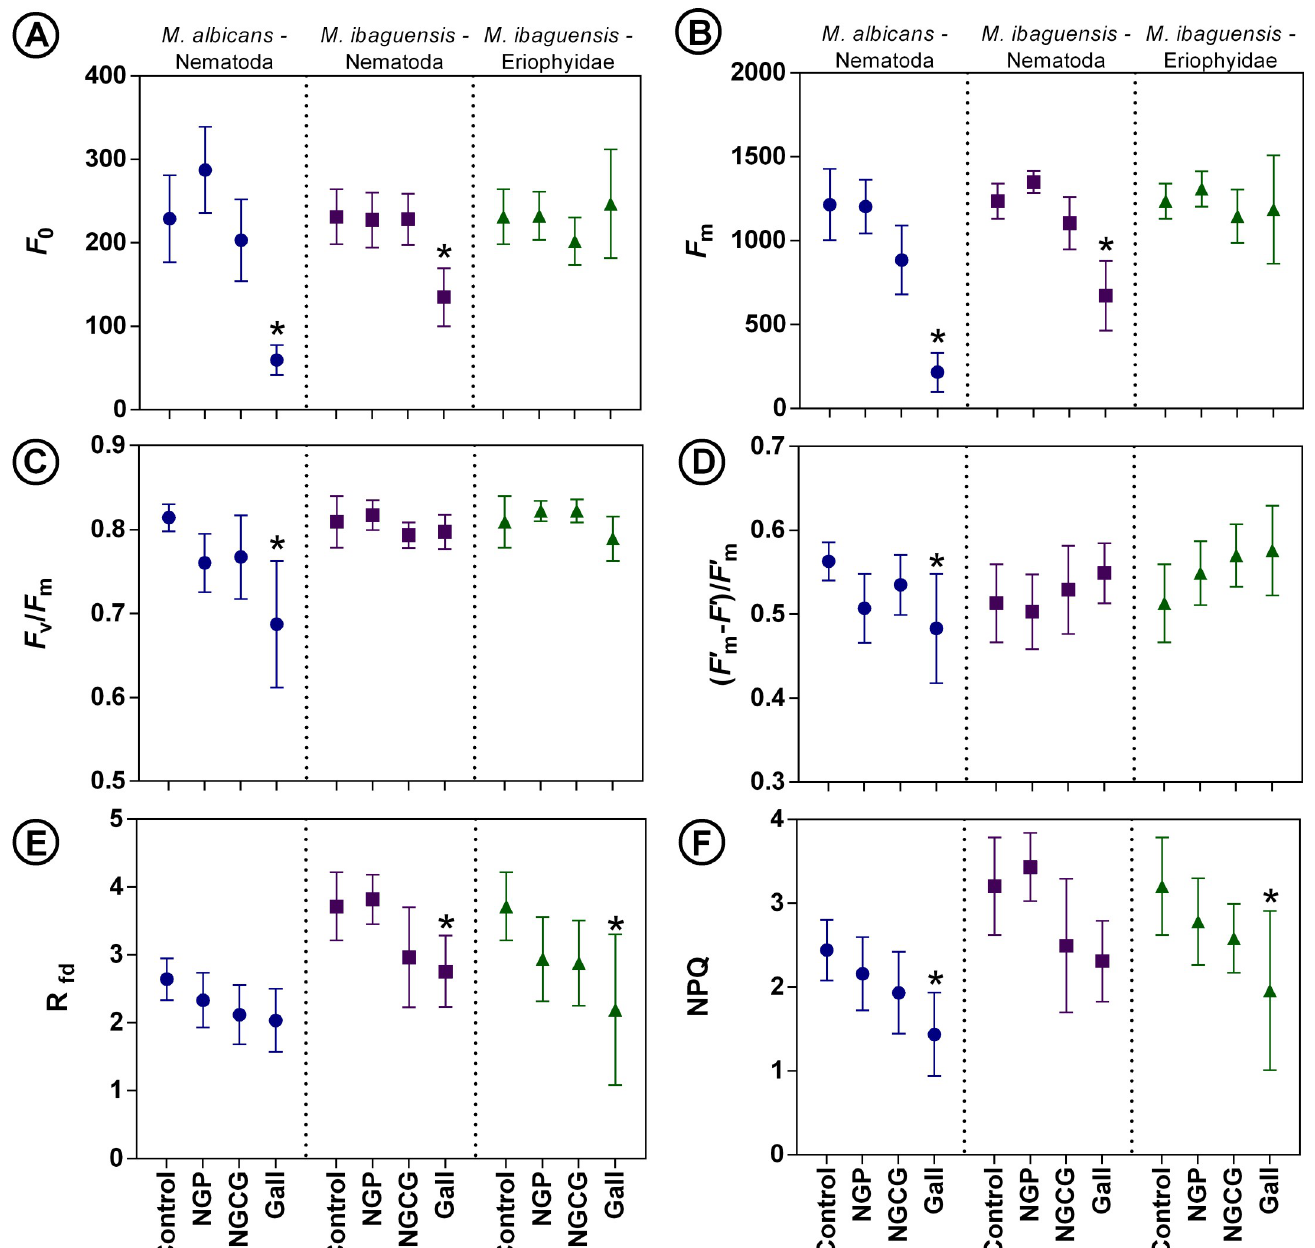
Fig 4. Photosynthetic parameters in leaves, non-galled portions of galled leaves (NGP), non-galled portions close to gall edge (NGCG), and galls induced by Ditylenchus gallaeformans (Nematoda) on Miconia albicans ; by D . gallaeformans on M . ibaguensis ; and by an unidentified Eriophyidae on M . ibaguensis . (A) F 0 (minimum fluorescence in dark-adapted state). (B) F m (maximum fluorescence in dark-adapted state). (C) F v /F m (maximum quantum yield of photosystem II). (D) ( F 0 m – F 0 )/ F 0 m (PSII operating efficiency). (E) R fd (instantaneous fluorescence decline ratio in light). (G) NPQ (instantaneous non-photochemical quenching during light adaptation). Bars indicate the means and standard deviations. Asterisks indicate significant differences ( P <